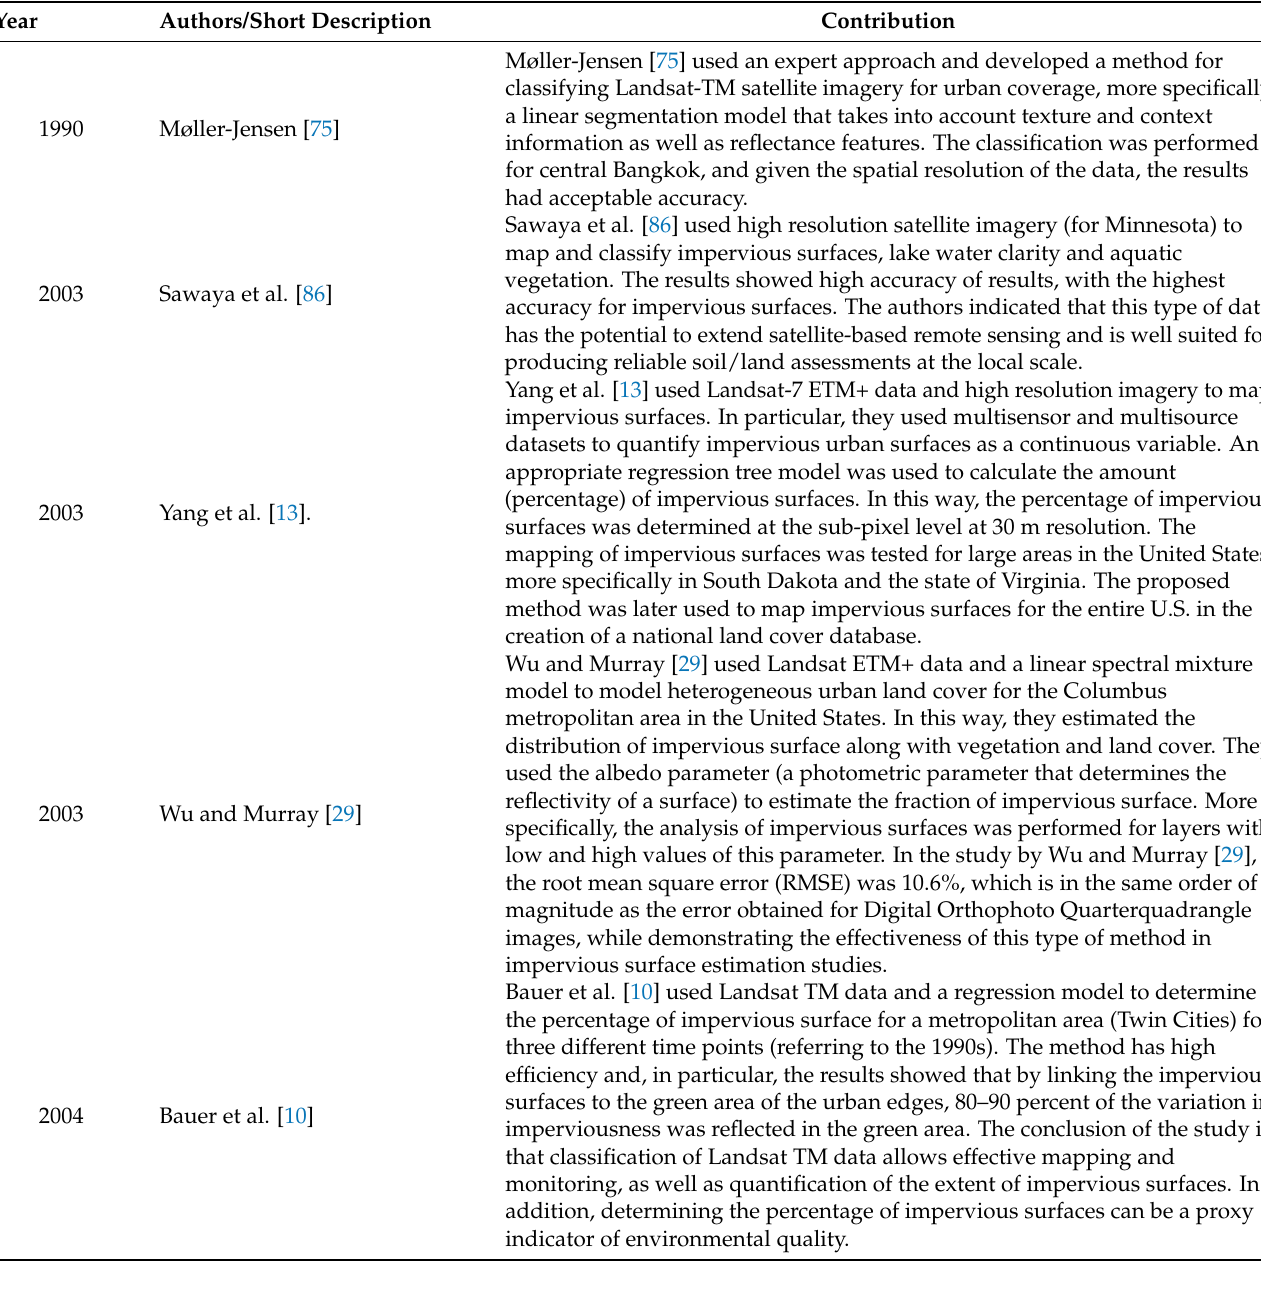
Table A1. Scientific approach—various methods to study impervious surfaces (including remote sensing and machine learning classification